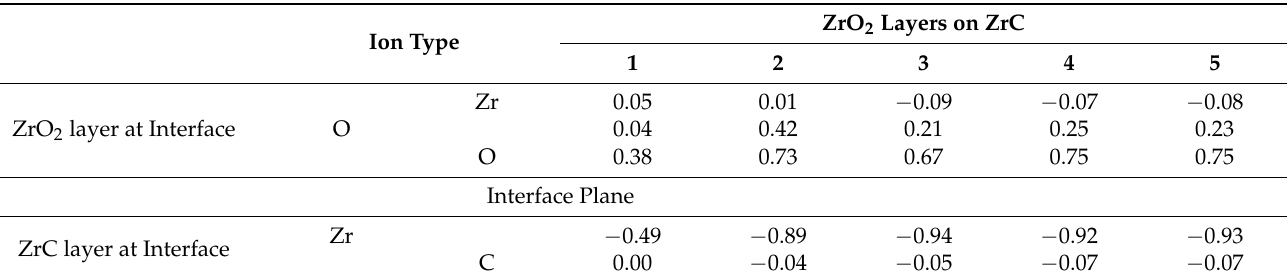
Table 5. Charge transfer analysis of the interfacial structure between ZrC(111) surface and